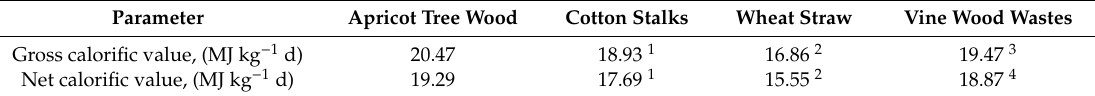
Table 2. Results of calorific value for tested apricot material in comparison with other materials. Parameter Apricot Tree Wood Cotton